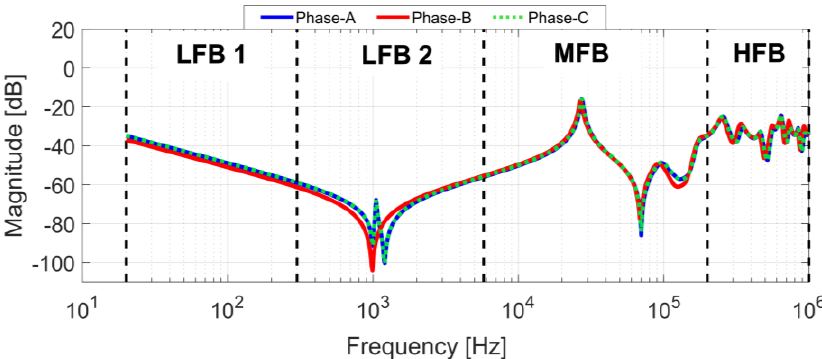
Figure 13. An illustration of frequency sub-bands structure in an OC transfer function.